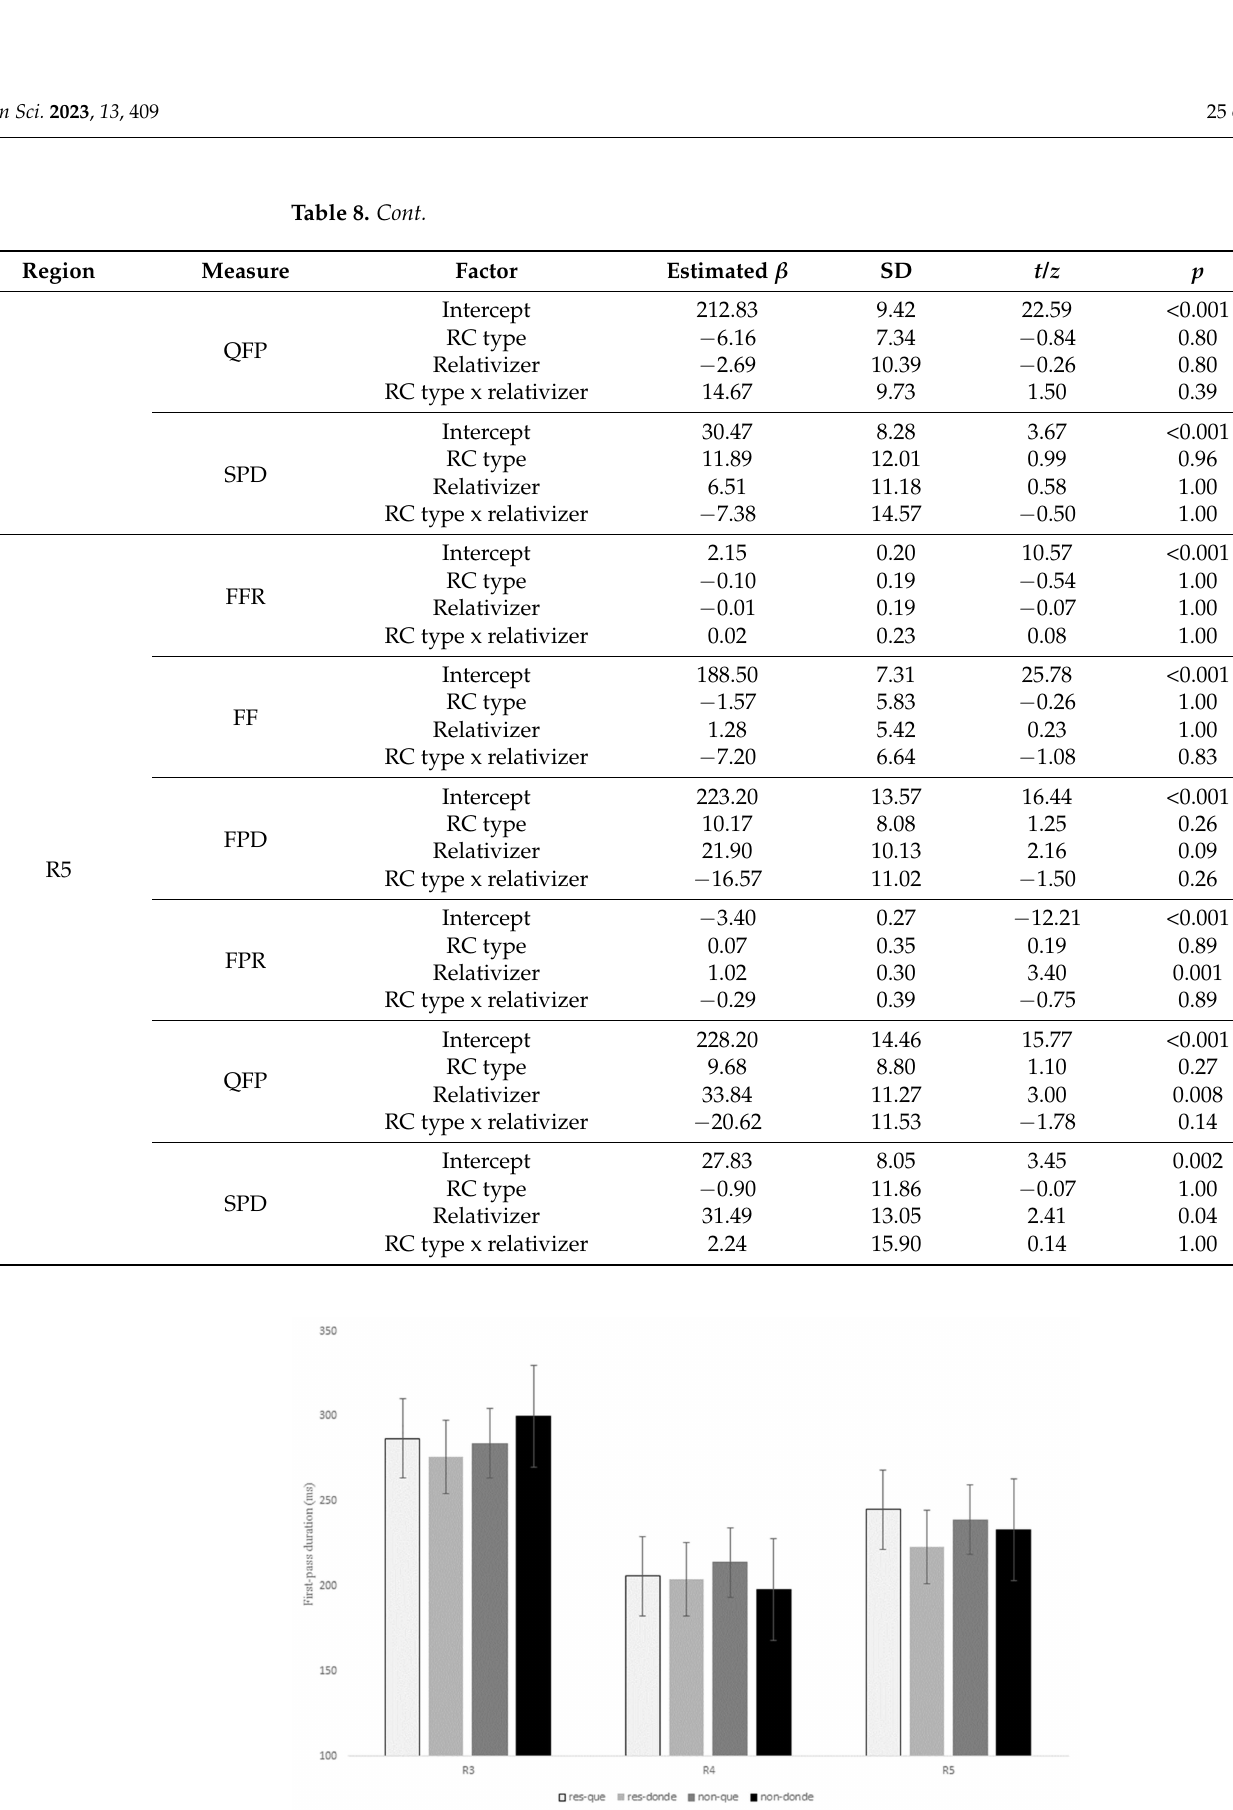
Figure 8. Reading time in milliseconds for the first-pass duration at regions 3, 4, and 5 for the contrast que versus donde in restrictive and non-restrictive